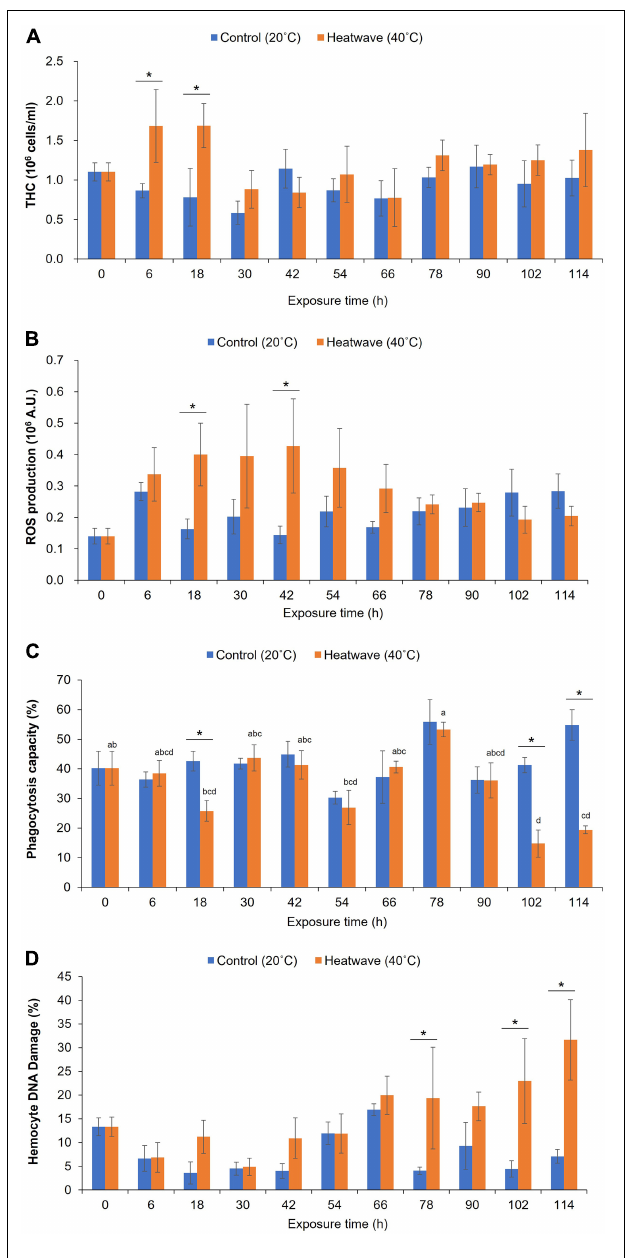
FIGURE 6 | (A) Total hemocyte count, (B) reactive oxygen species (ROS) production, (C) phagocytosis capacity, and (D) DNA damage of hemocytes of Mytilisepta virgata . Values are presented as the mean ± standard error. Asterisk (*) represents significant ( t -test, P < 0.05) differences between control and treatment. Different letters (a–d) on histograms indicate statistical (one-way ANOVA, P < 0.05) differences among exposure times within each experimental